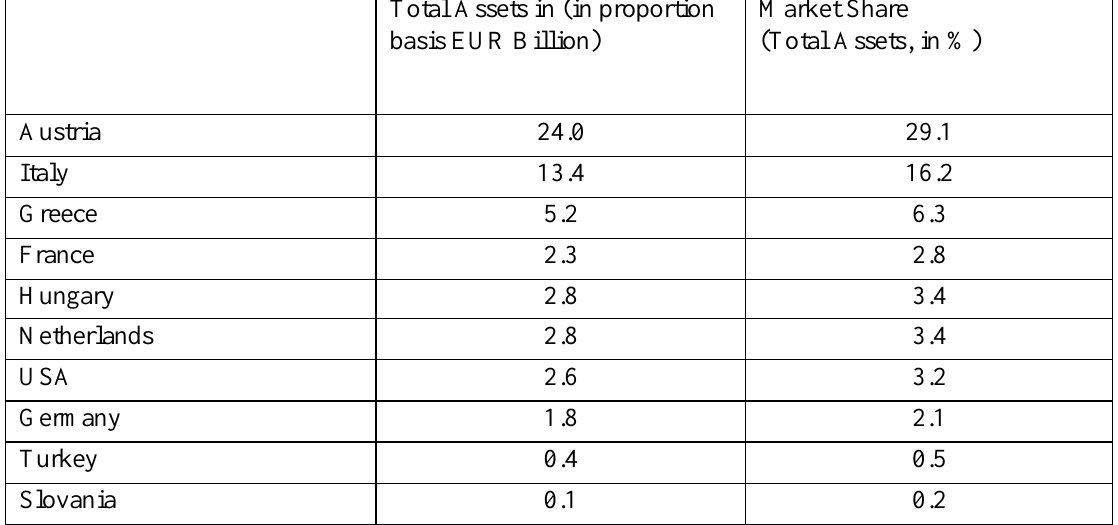
Table 5a. International Banking Group in South-East European Countries Including Accession Countries, as of